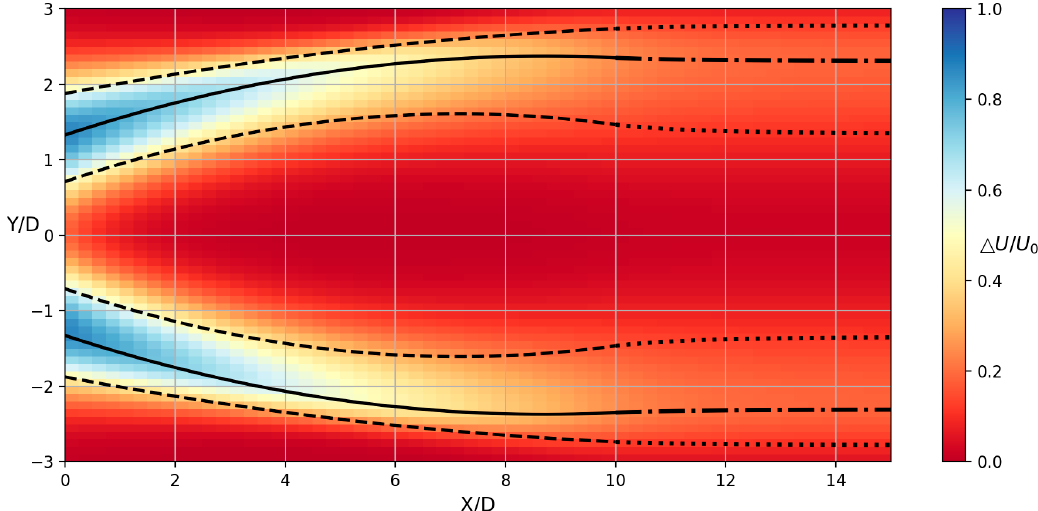
Figure 4. The velocity contour of Case 2 (Counter-rotating twin turbines (backward)). The color bar is the velocity deficit, the black solid lines represent the position of the maximum velocity deficit, and the black dashed lines represent the deviations of the double semi Gaussian functions.